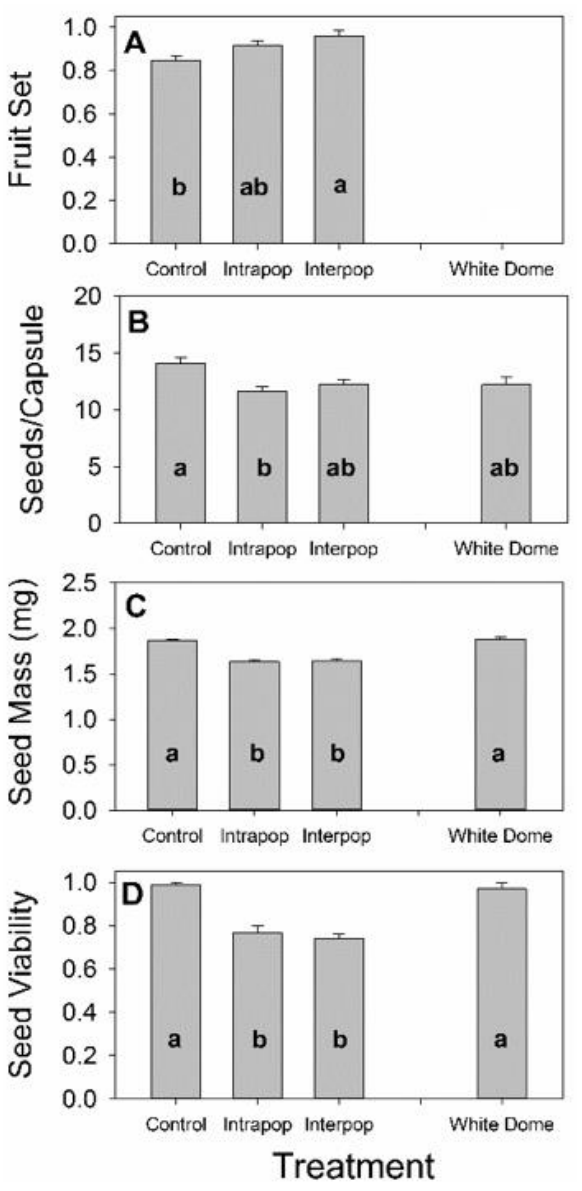
Figure 1. Results of the pollen addition experiment at the Shinob Kibe population in 2018, showing the mean ( A ) fruit set (fruit to flower ratio), ( B ) filled seeds per capsule, ( C ) seed mass, and ( D ) seed viability based on tetrazolium testing [20] per treatment. Treatments are control (open-pollinated with no manipulation), intrapop (pollen added from the Shinob Kibe population), and interpop (pollen added from the White Dome population). Data from White Dome are included when available. For each response variable (fruit set, seed number per capsule, seed mass, and seed viability) bars that contain the same letter are not significantly different at p < 0.05. An asterisk indicates that data are not available. See Appendix A for full statistical